Question: What style of plot is this figure drawn as?
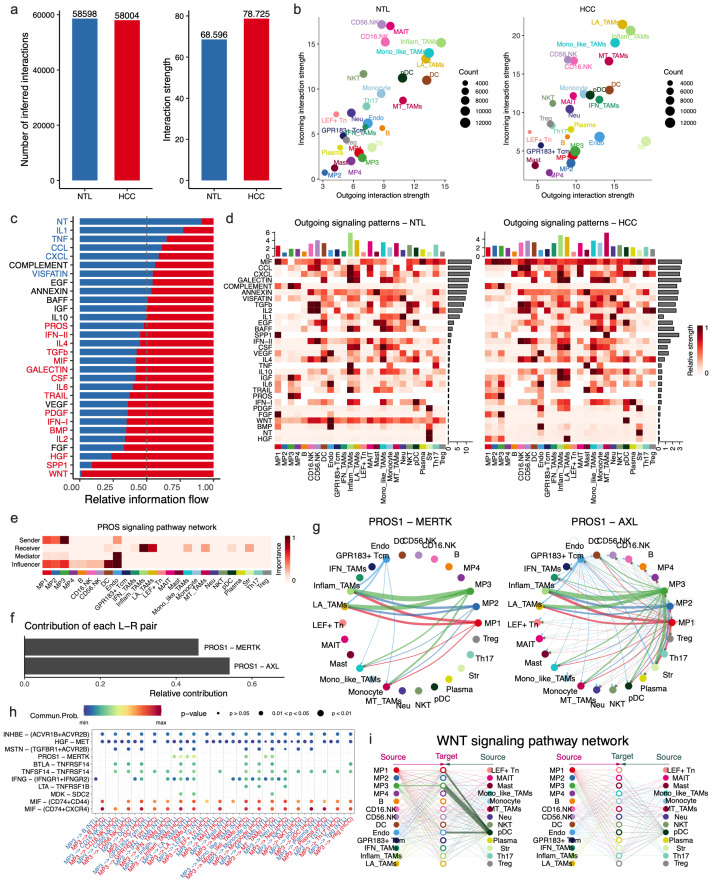
Answer: heatmap